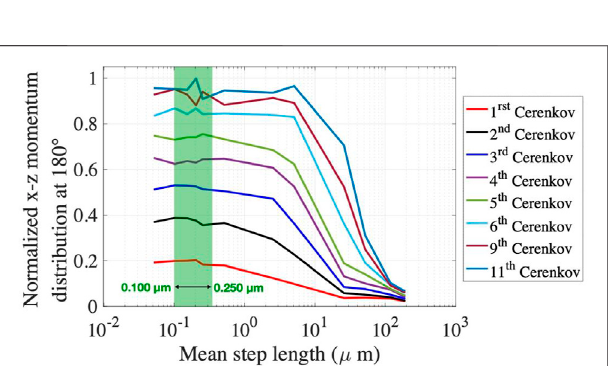
FIGURE 7 | Distribution of the i th emitted Cerenkov photons momentum at 180 ° compared to the gamma direction, projected on the x-z plane, as a function of the electron mean step